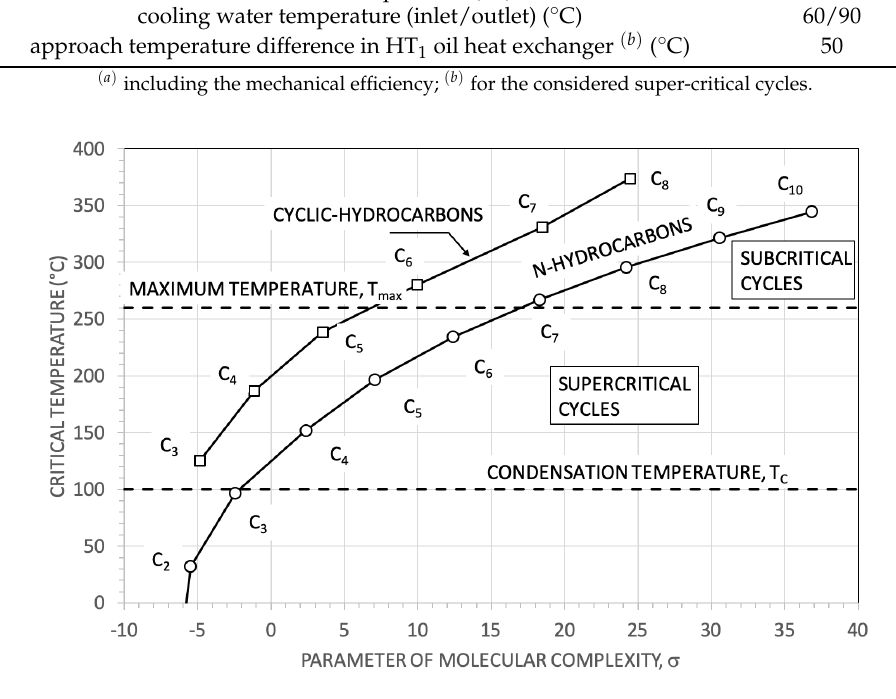
Figure 2. Critical temperature as a function of the molecular complexity parameter for linear (normal) hydrocarbons and cyclic